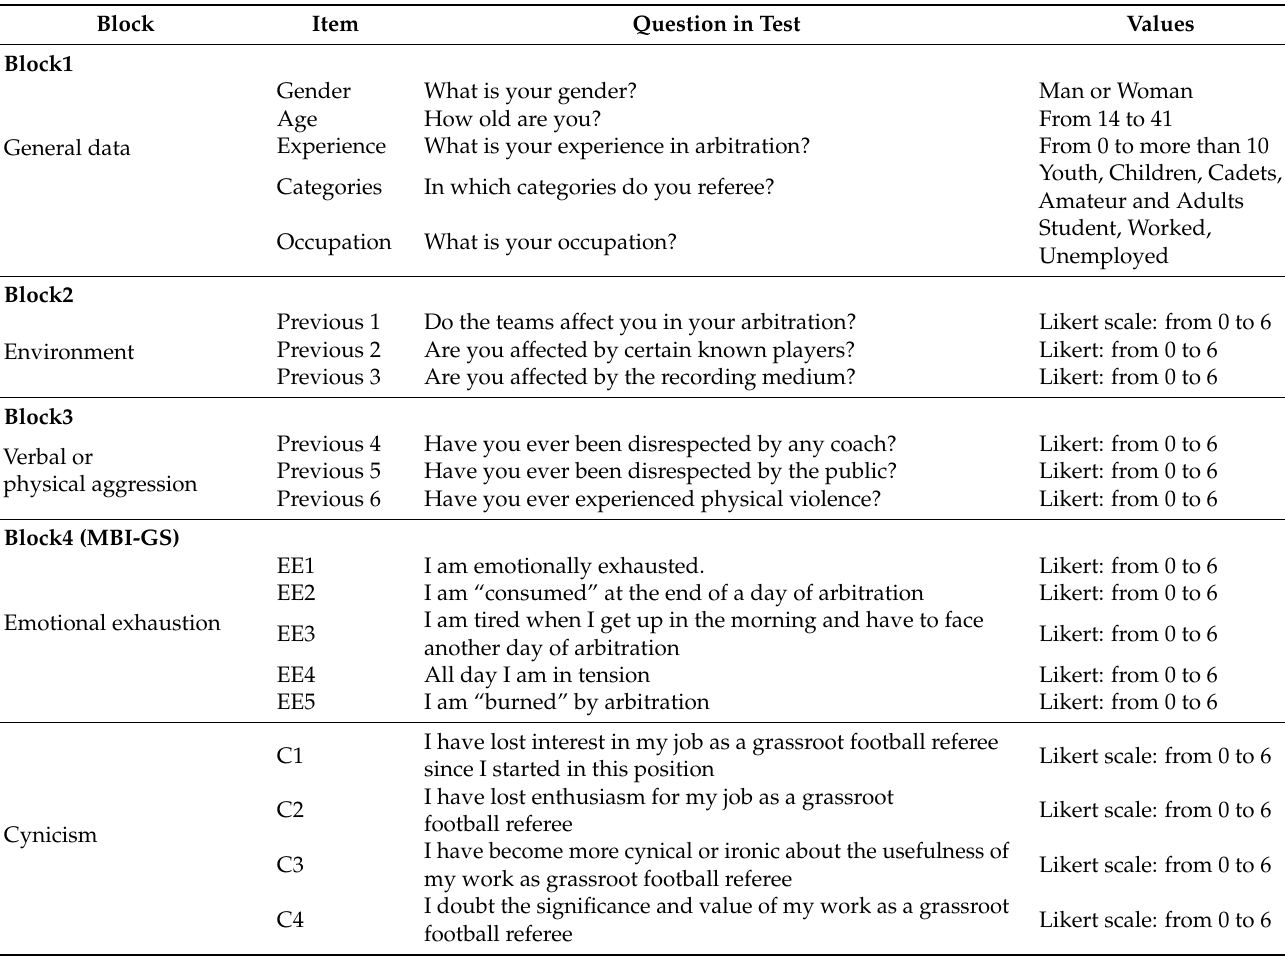
Table 2. Structure of the MBI-GS questionnaire adapted to the characteristics of the activity of the participants of the group of grassroot football